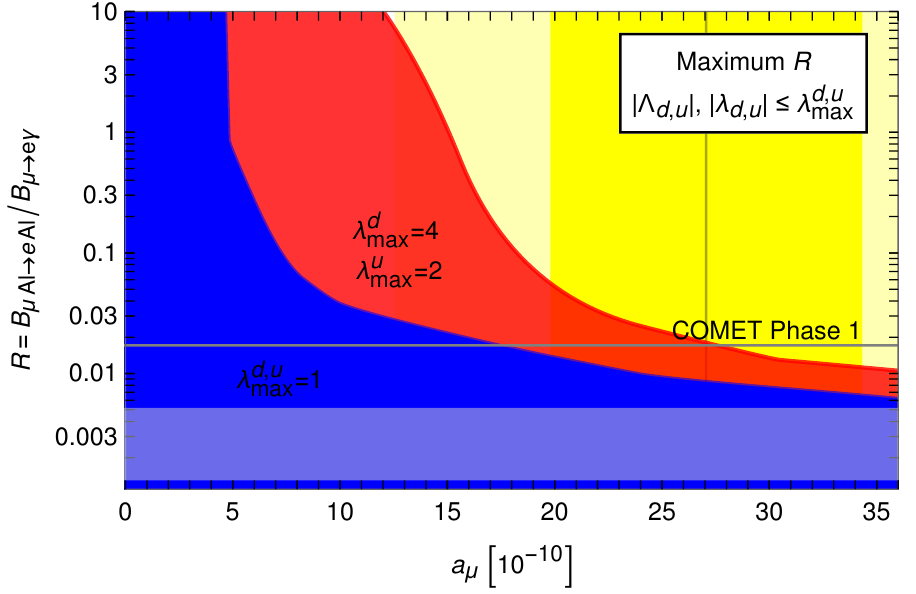
Figure 14. The correlation between (cid:22) e conversion and (cid:22) e(cid:13) , as a function of a (cid:22) ; equivalently, ! ! the maximum value for (cid:22) e conversion for a given value of (cid:22) e(cid:13) . The possible ranges have ! ! been obtained from a parameter scan respecting the constraints of section 4.1. In particular, in the outer red region, the (cid:21) ’s take the maximum values allowed in section 4.1; in the blue inner region the (cid:21) ’s are constrained to be less than unity. The vertical yellow band is de(cid:12)ned as in (cid:12)gure 5; the horizontal light gray band indicates the expectation corresponding to dipole dominance as in (cid:12)gure 10. The thin horizontal line indicates the minimum value of R (Al) for which COMET Phase 1 is sensitive to (cid:22) e conversion, given the current MEG limit on (cid:22) e(cid:13) ! !